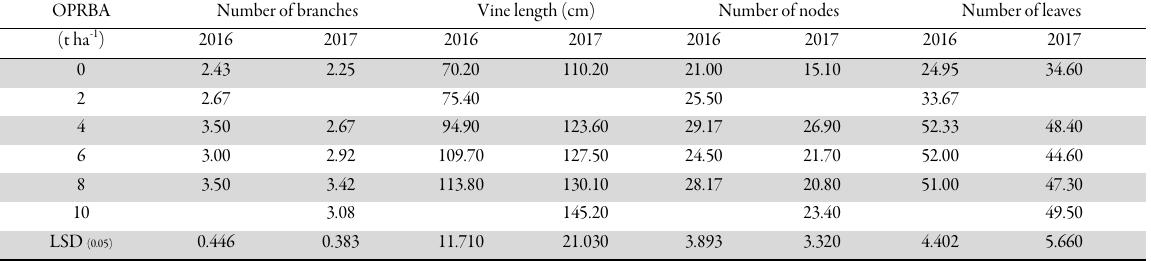
Table 2. Number of branches, vine length, number of nodes and number of leaves of sweet potato as influenced by oil palm refuse bunch ash (OPRBA) rate OPRBA Number of